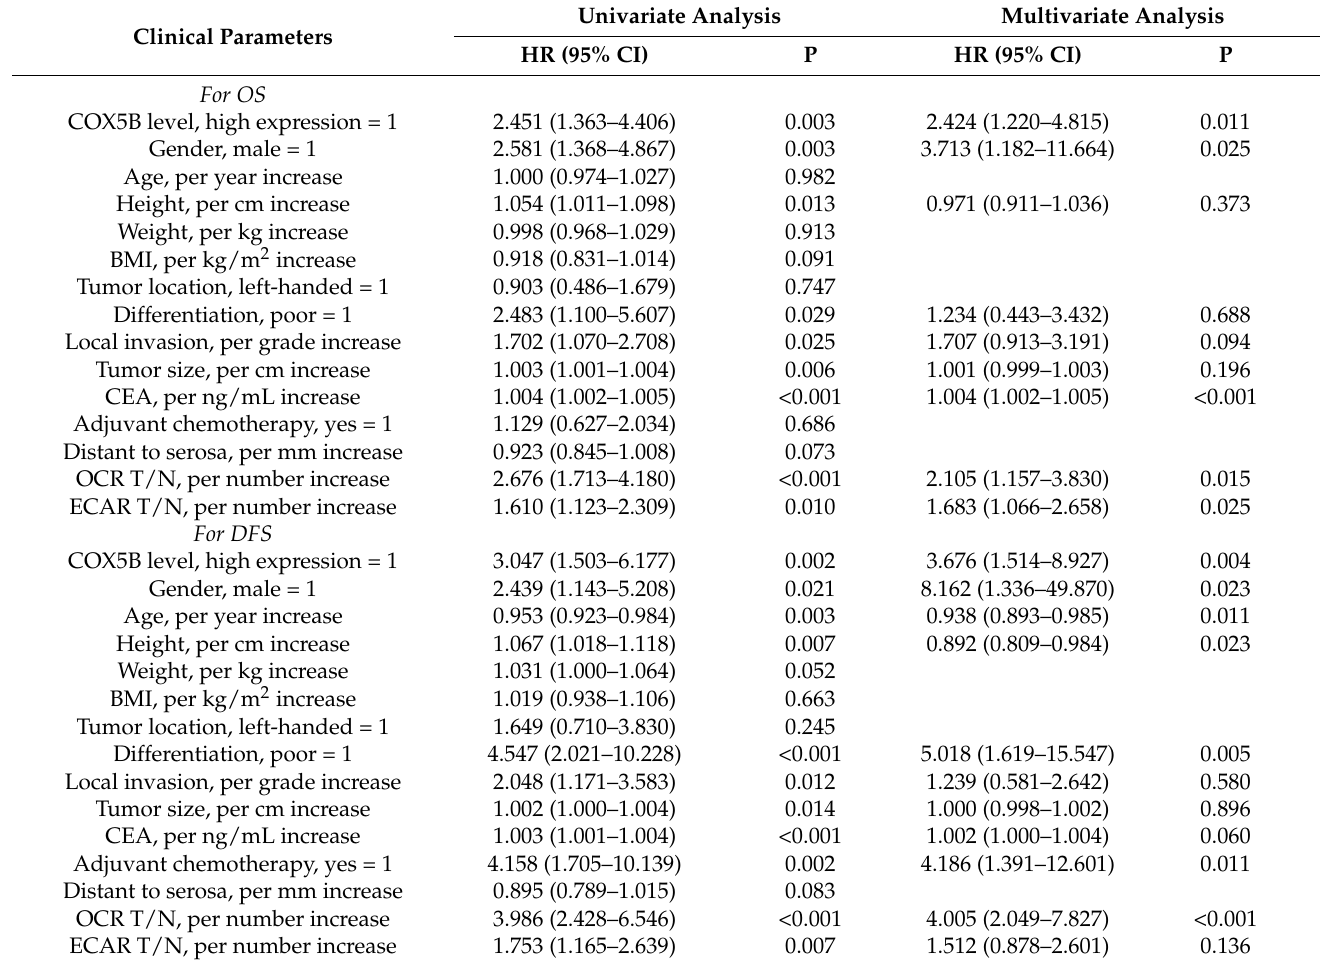
Table 1. Cox proportional hazard analysis for association between clinical factors and OS or